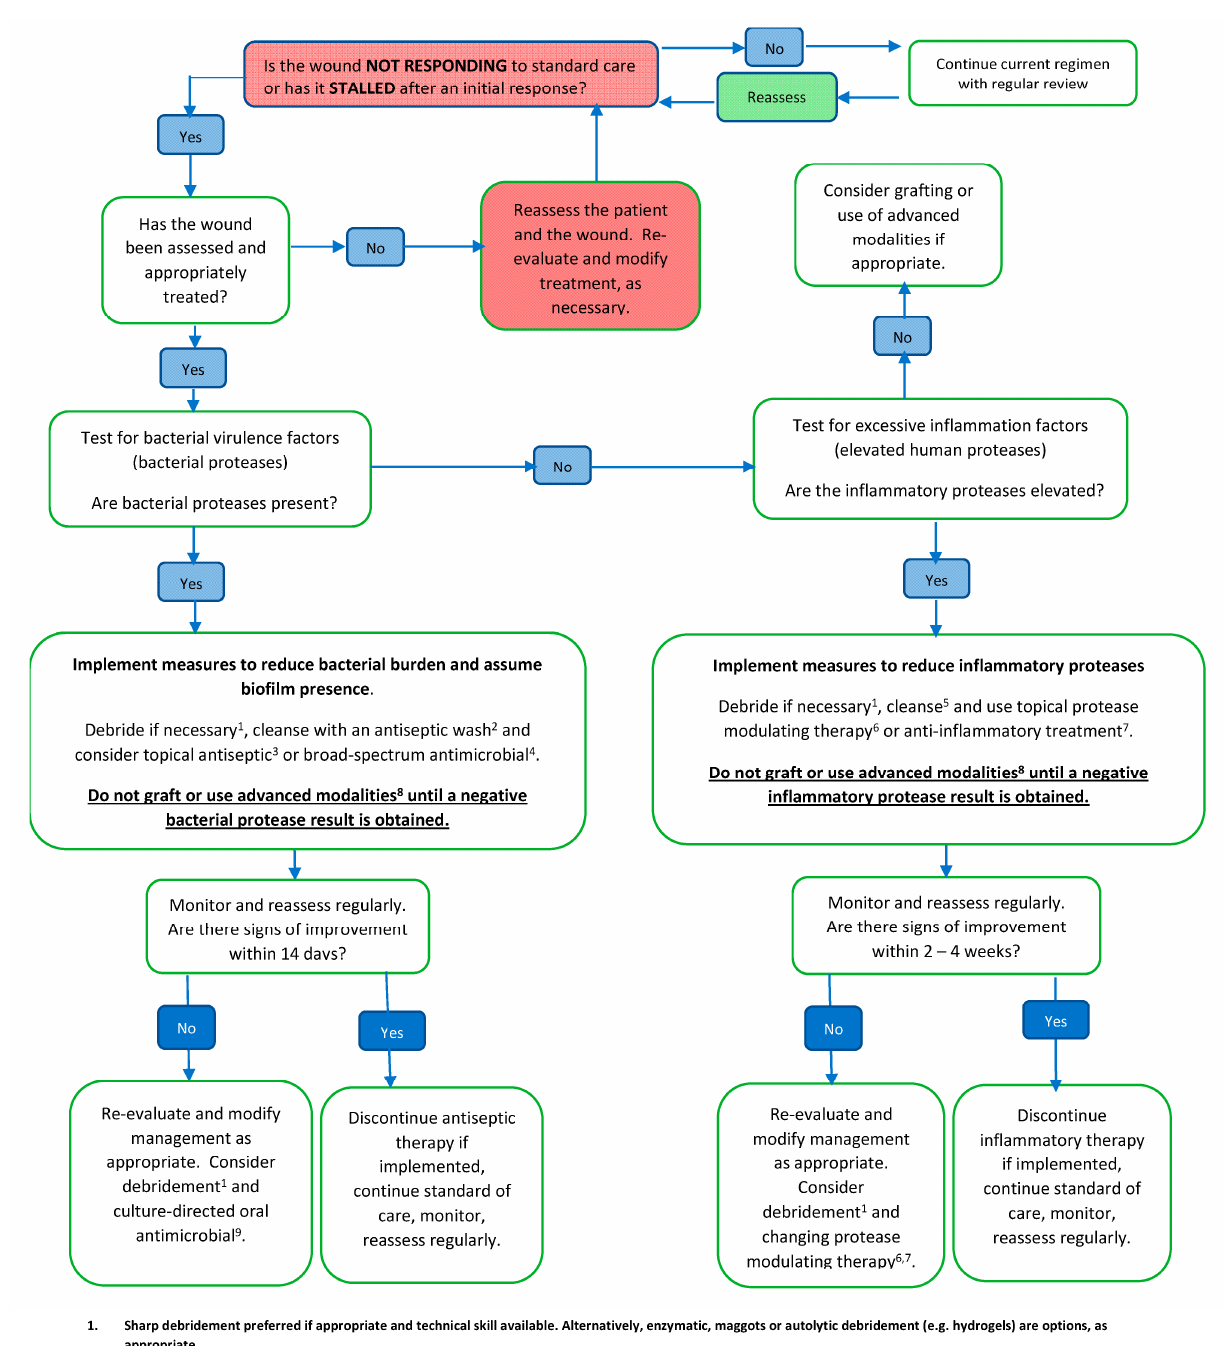
Figure 2. Suggested pathway for the use of point of care wound diagnostic tests [17,18].